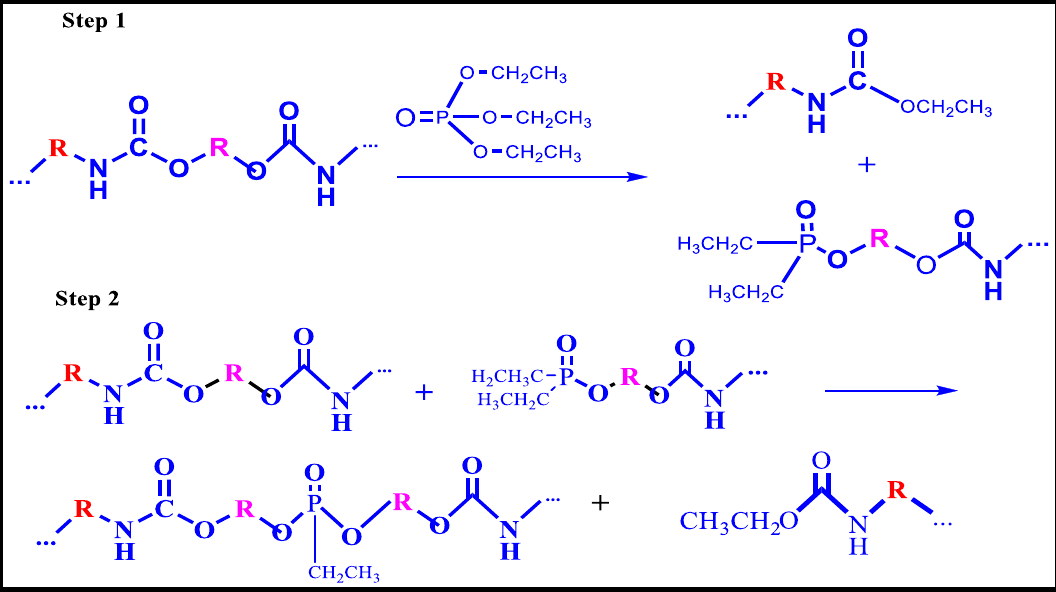
Figure 14. Phosphorolysis of Polyurethane [117].